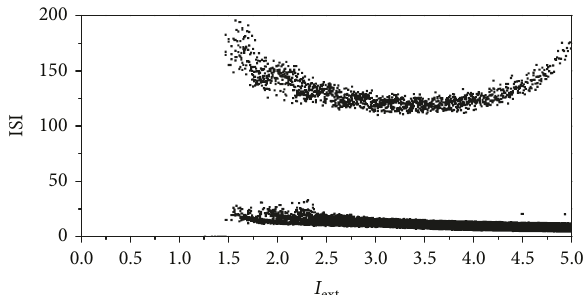
Figure 5: Bifurcation diagram with the increasing of external direct current 𝐼 ext . 𝐷 = 0.2